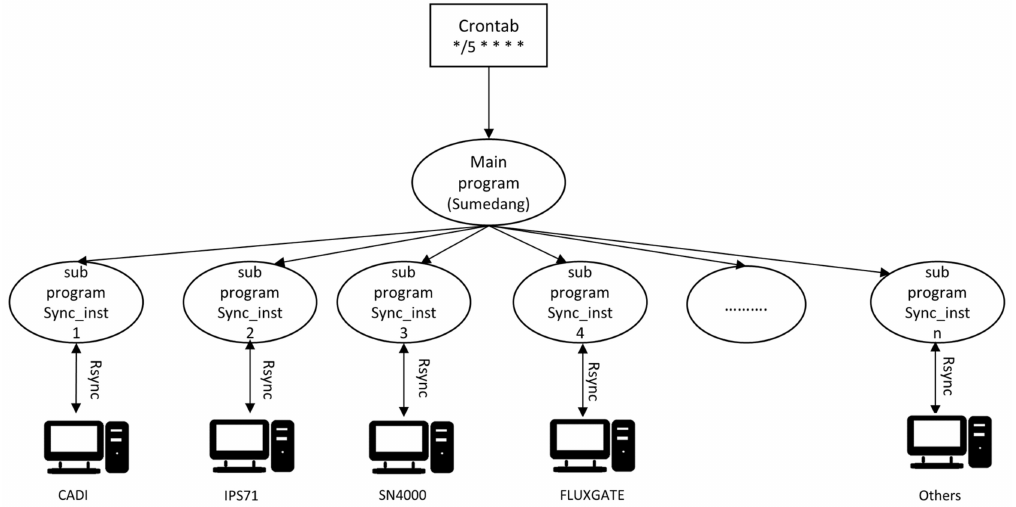
Figure 2. The synchronization process between the site server and the instrument’s PC at the Sumedang site.